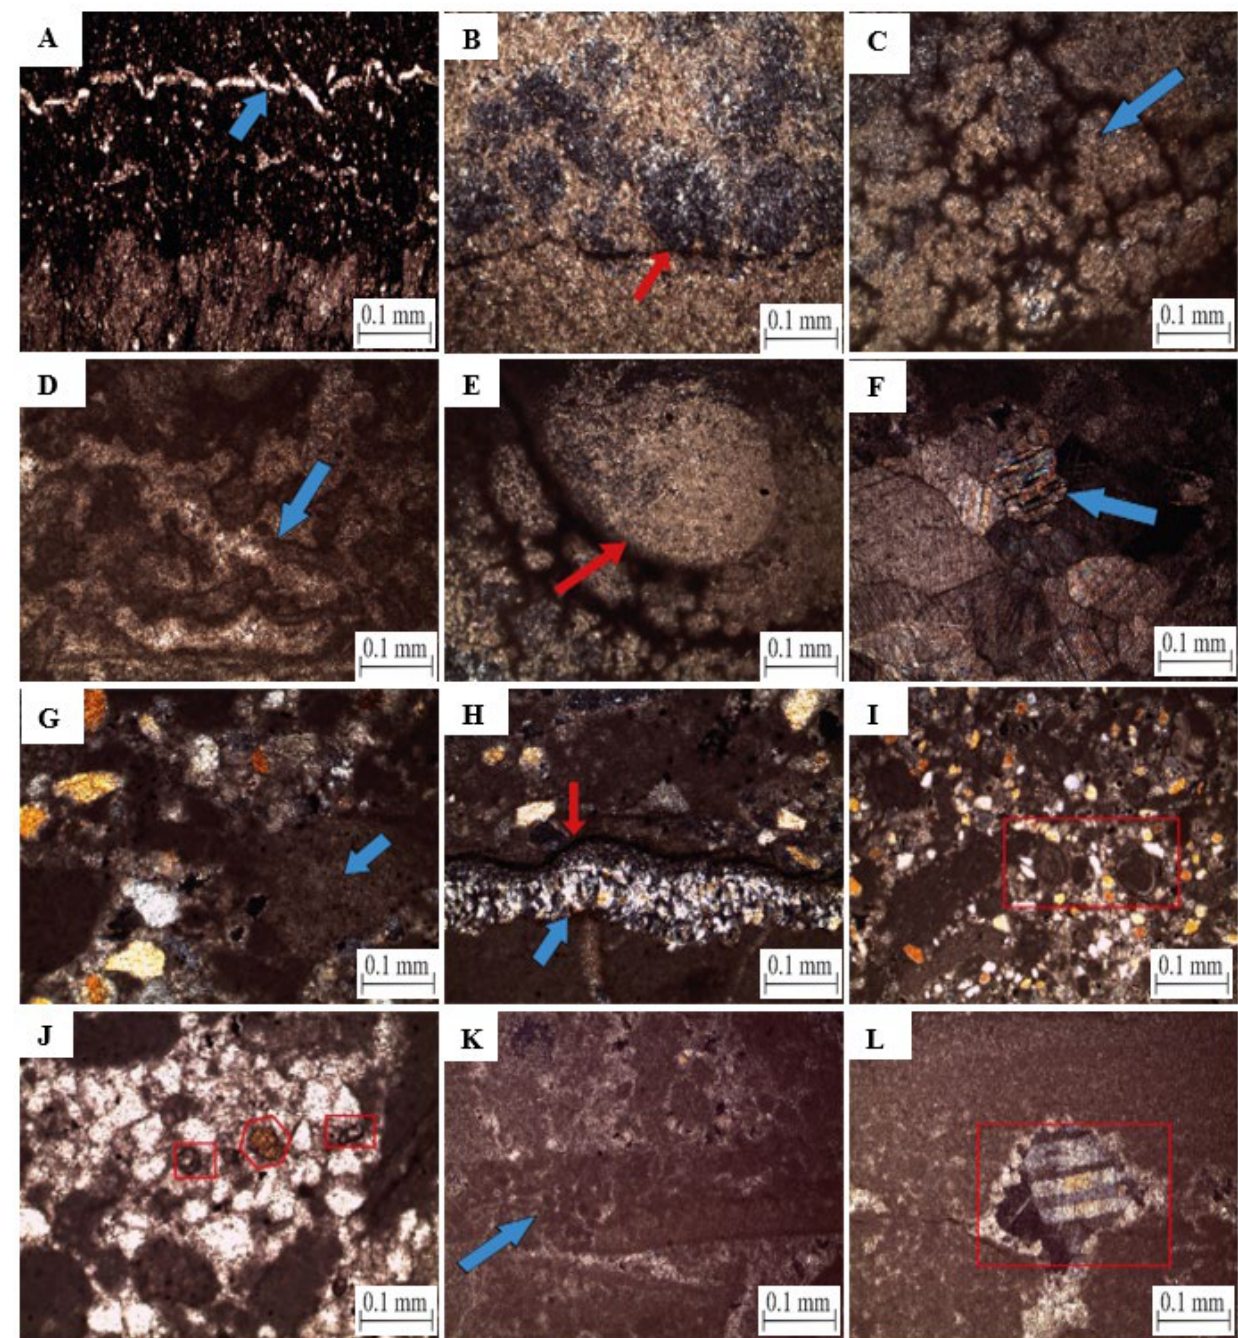
Figure 8. Photomicrographs of the Dol. III microfacies of the Abbottabad Formation. ( A ) Microbial lamination (blue arrow) and organic matter (KA-8; PPL. 4×). ( B ) Chert patches with stylolite vein (red arrow) (KA-35; XPL. 4×). ( C ) Algae bioclast (blue arrow) (KA-56; XPL. 4×). ( D ) Dolomitized algal mats (KA-56; XPL. 4×). ( E ) Dolomitized algae bioclast (red arrow) (KA-56; XPL. 4×) ( F ) Spary calcite (blue arrow) (KA-56; XPL. 4×). ( G ) Algal mats (blue arrow) partially dolomitized (KA-63; XPL. 10×). ( H ). Chalcedony vein (blue color) and hematite vein (red arrow) along algal mats (KA-63; XPL. 10×). ( I ) Rectangle showing pellets (KA-63; XPL. 4×). ( J ) Rectangle showing zircon and polygon showing tourmaline crystals (KA-63; XPL. 10×). ( K ) Algal mat (blue arrow) (KA-67; XPL. 4×). ( L ) Rectangle showing cavity filled by calcite and then dolomitized (KA-67; XPL. 4×).